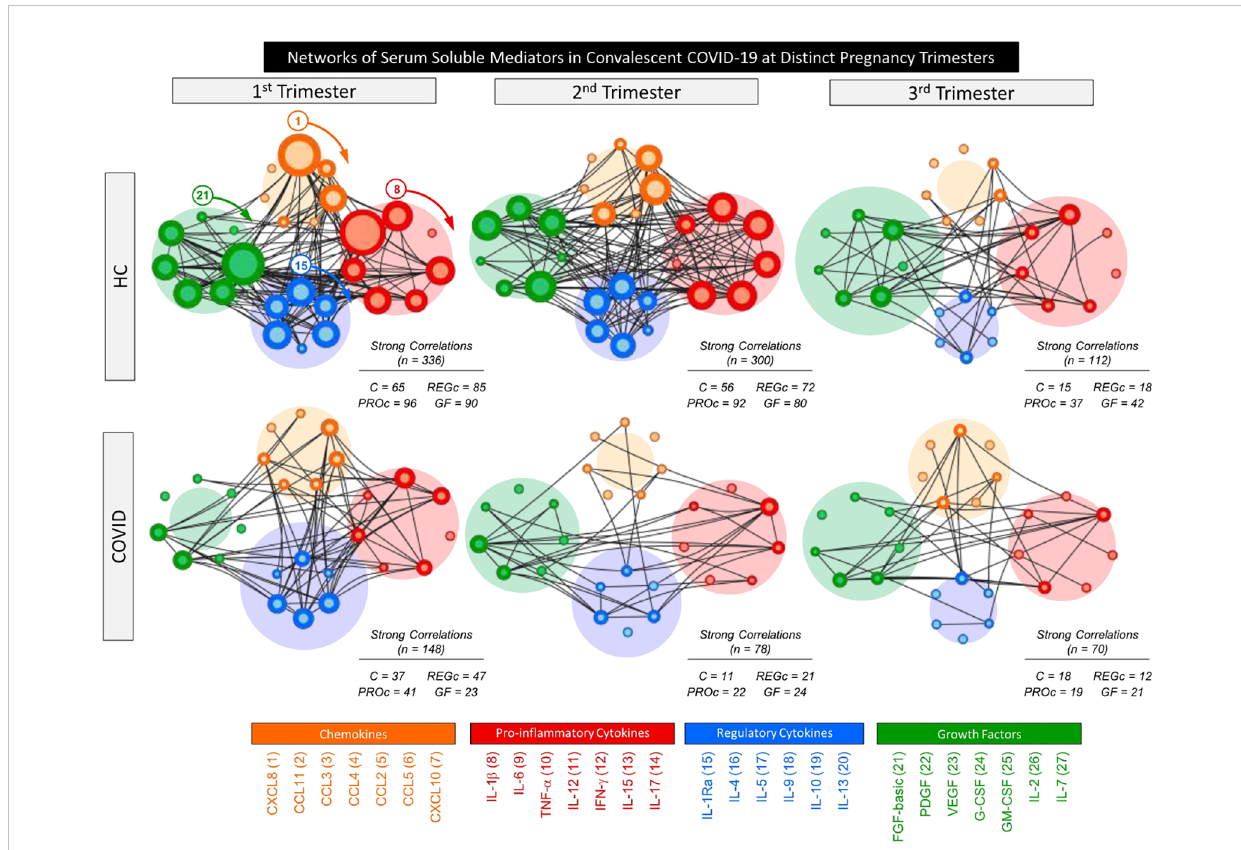
FIGURE 4 Networks of serum soluble mediators in convalescent COVID-19 patients at distinct pregnancy trimesters. Comprehensive networks were assembled for serum chemokines, pro-in fl ammatory cytokines, regulatory cytokines, and growth factors observed in pregnant women with convalescent COVID-19 at 3-20 weeks after symptoms onset (COVID, n=89), with pre-pandemic non-infected pregnant women as a Healthy Control (HC, n=52). The HC and COVID-19 groups were further categorized into subgroups according to pregnancy trimester, referred to as: 1 st (HC=21 and COVID=7), 2 nd (HC=18 and COVID=34) and 3 rd (HC=21 and COVID=48). The measurements were taken by high-throughput multiplex bead array as described in Material and Methods. Data analyses were carried out by Pearson and Spearman rank tests with only signi fi cant strong correlations (p<0.05 and “ r ” scores ≥ |0.67|) employed to construct the comprehensive networks. Cluster layout networks were assembled, comprising 4 categories of serum soluble mediators as follows: - Chemokines – C (orange nodes – 1=CXCL8; 2=CCL11; 3=CCL3; 4=CCL4; 5=CCL2, 6=CCL5 and 7=CXCL10); Pro-in fl ammatory – PROc (red nodes – 8= IL-1 b ; 9=IL-6; 10= TNF- a ; 11=IL-12; 12= IFN- g ; 13=IL-15 and 14=IL- 17); Regulatory cytokines – REGc (blue nodes – 15=IL-1Ra; 16=IL-4; 17=IL-5; 18=IL-9; 19=IL-10 and 20=IL-13), and Growth Factors – GF (green nodes – 21=FGF-basic; 22=PDGF; 23=VEGF; 24=GCSF; 25=GM-CSF; 26=IL-2 and 27=IL-7). Node border thickness is proportional to the number of strong correlations. Connecting edges (black lines) are used to link pairs of serum soluble mediators presenting signi fi cant correlations. The number of strong correlations (C, PROc, REGc and GF) observed for each network is provided in the fi gure and used for comparative analysis between COVID and HC, as well as amongst subgroups. The circular background area is proportional to the number of strong correlations of each cluster within the respective